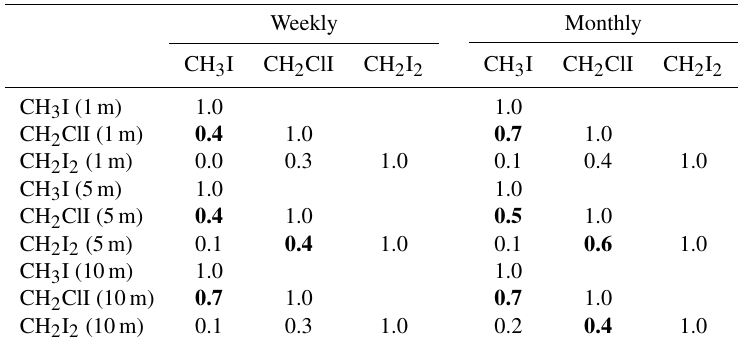
Table 1. R 2 value (Pearson’s correlation coefficients, p < 0 . 05) for the individual iodocarbon data based on both weekly data and monthly average. The significant correlations are highlighted with bold font. Weekly